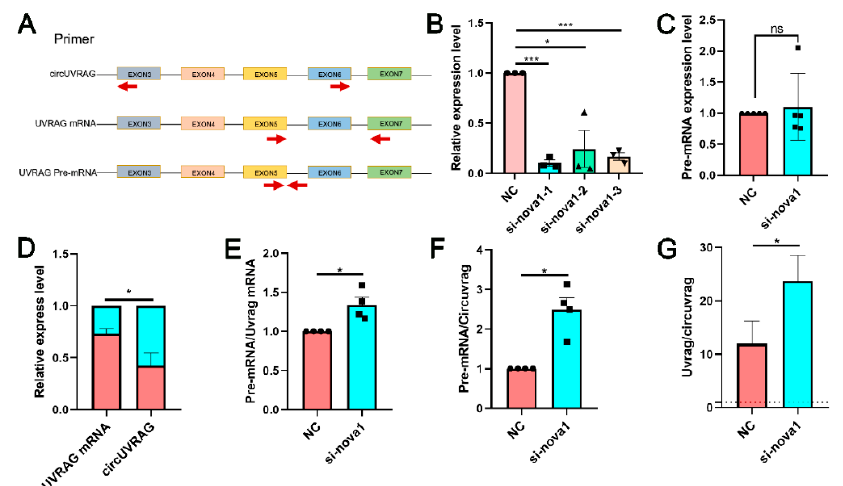
Figure 5. Silencing NOVA1 reduces the expression of circUVRAG and linear UVRAG mRNA without affecting the expression of UVRAG pre-mRNA. ( A ). The schema of primer design for circUVRAG, UVRAG mRNA, and UVRAG pre-mRNA. ( B ). Three siRNA fragments are designed to reduce the expression of NOVA1 mRNA. Among these, siRNA1 is the most efficient and stable ( n = 3). ( C ). Knockdown of NOVA1 has no effect on the abundance of UVRAG pre-mRNA ( n = 5). ( D ). Both circUVRAG and UVRAG mRNA decrease after knocking down NOVA1. CircUVRAG is reduced significantly more than UVRAG mRNA ( n = 5). ( E – G ). The ratio of pre-mRNA to UVRAG mRNA ( E ) ( n = 4) and circUVRAG ( F ) ( n = 4) increases and the ratio of linear UVRAG mRNA to circUVRAG ( G ) ( n = 7) also increases after reducing NOVA1. * p < 0.05, *** p < 0.001.